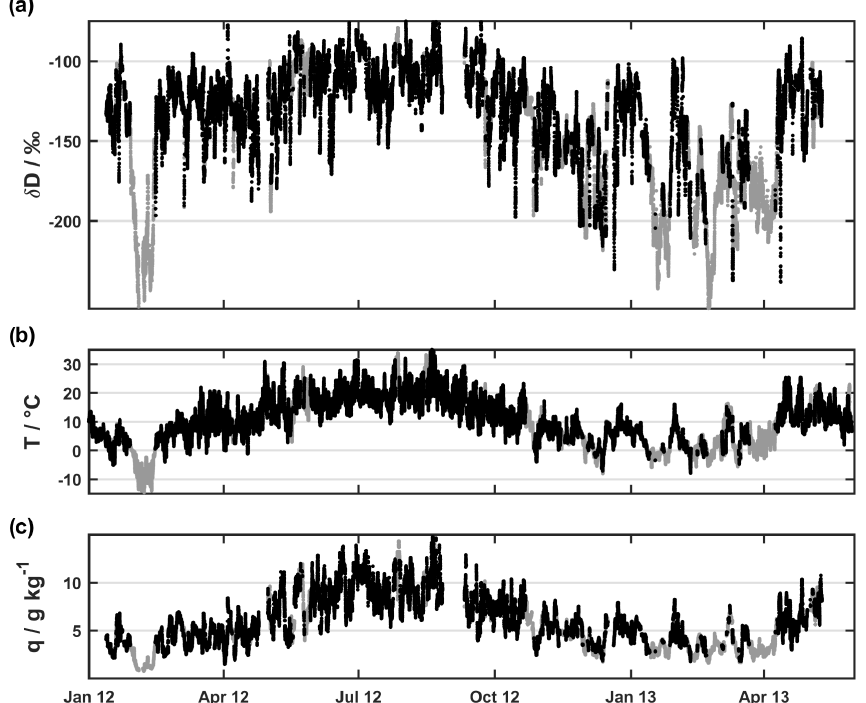
Figure 6. Measurements in Karlsruhe from January 2012 to May 2013 30m above ground level (10min averages). Black: 5-day back trajectories originate from the west; gray: 5-day back trajectories originate from the east. (a) δ D of water vapor. Gaps in the time series are caused by instrumental issues with analyzer and calibration device. (b) Air temperature ( T ). (c) Specific humidity ( q